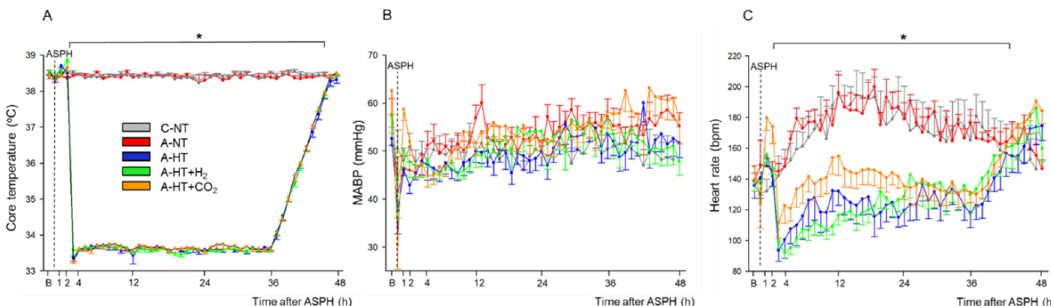
Figure 2. Core temperature ( A ), mean arterial blood pressure (MABP) ( B ), and heart rate ( C ) data in the time controls and in the asphyxia groups during baseline (B), in the last minute of 20 min asphyxia (ASPH), and the 48 h survival period. The core temperature and the heart rate values were significantly higher in the normothermic groups (control-normothermia C-NT and asphyxia-normothermia A-NT) compared to the hypothermic ones (asphyxia-hypothermia A-HT, A-HT + H 2 , and A-HT + CO 2 ); however, there were no significant di ff erences in MABP. Data are shown as mean ± SEM. p < 0.05 * normothermia vs. hypothermia groups.